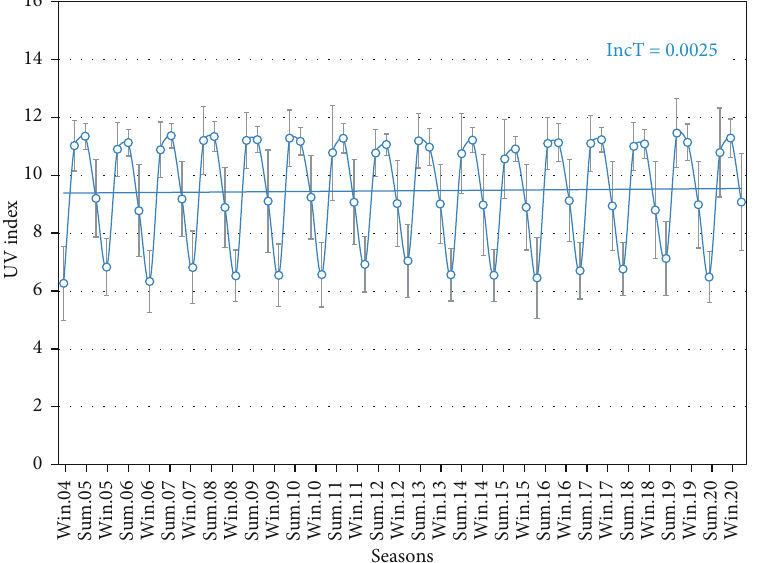
Figure 6: Time series variations in the seasonal UVI (with standard deviation error bars) on the campus of KAU during the study